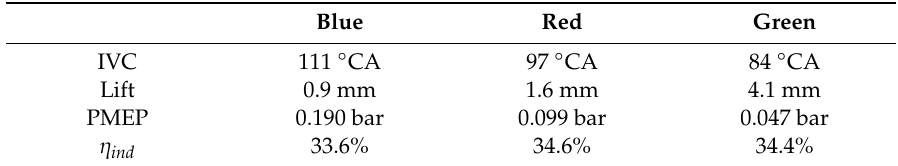
Table 3. pV diagram experiments details. IVC – intake valve closing; PMEP – pumping mean e ff ective